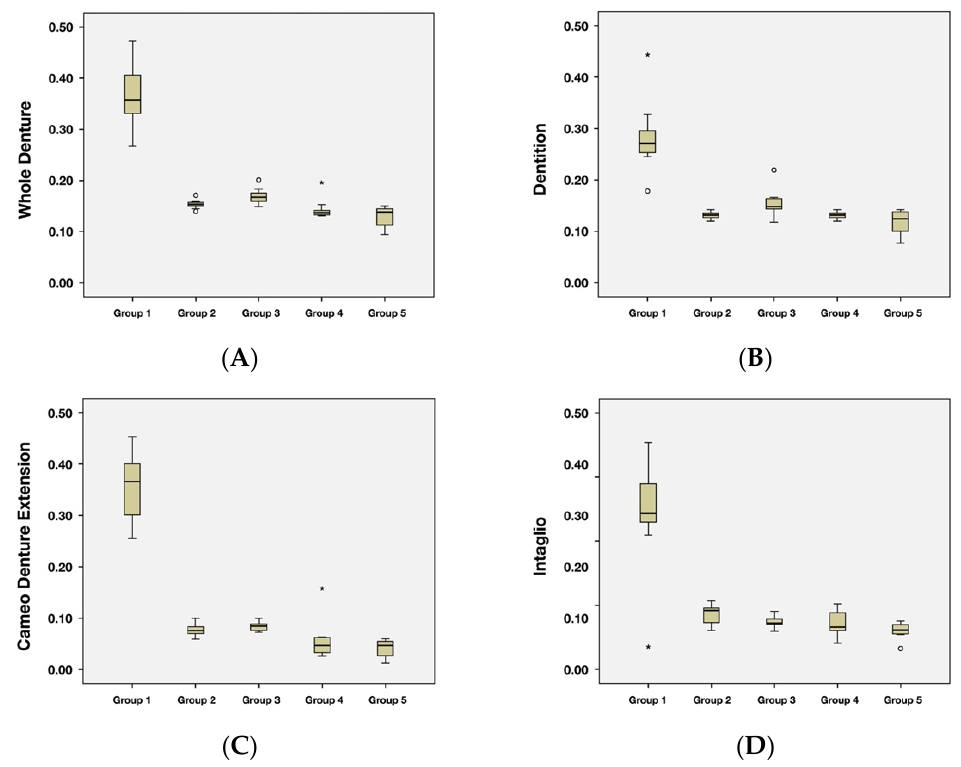
Figure 3. Box plot charts of RMS values. ( A ) Whole denture. ( B ) Dentition. ( C ) Cameo denture extension. ( D ) Intaglio.